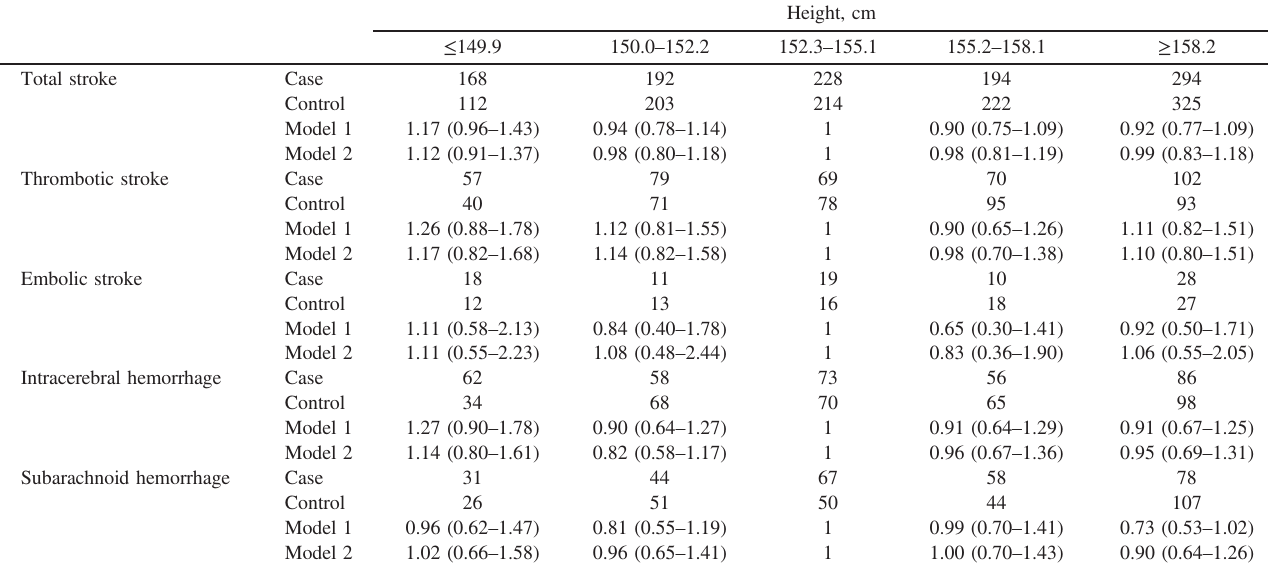
Table 4A. Multivariable-adjusted odds ratios and 95% con fi dence intervals of stroke and its subtypes according to height in women aged 40 – 59 years, Aichi, Japan